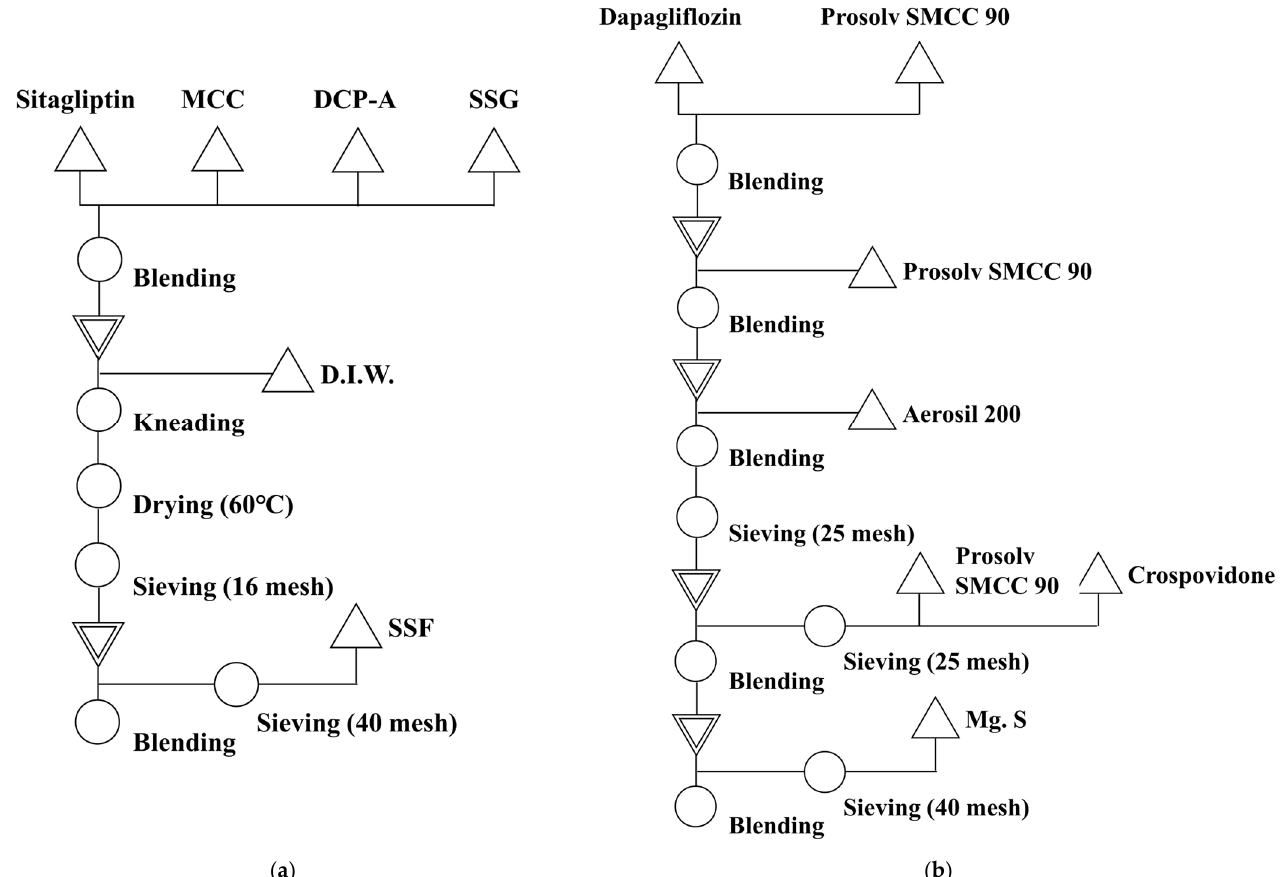
Figure 2. Manufacturing process flow chart of sitagliptin phosphate monohydrate granules ( a ) and dapagliflozin propanediol hydrate mixture powder ( b ).